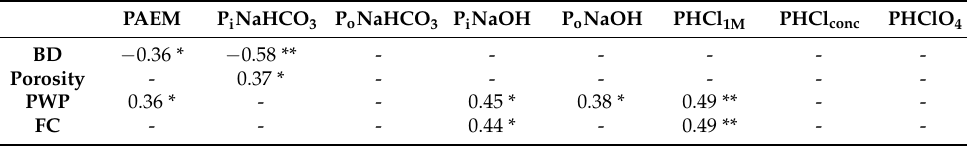
Table 5. Spearman’s correlations between P fractions and soil physical fertility-related parameters